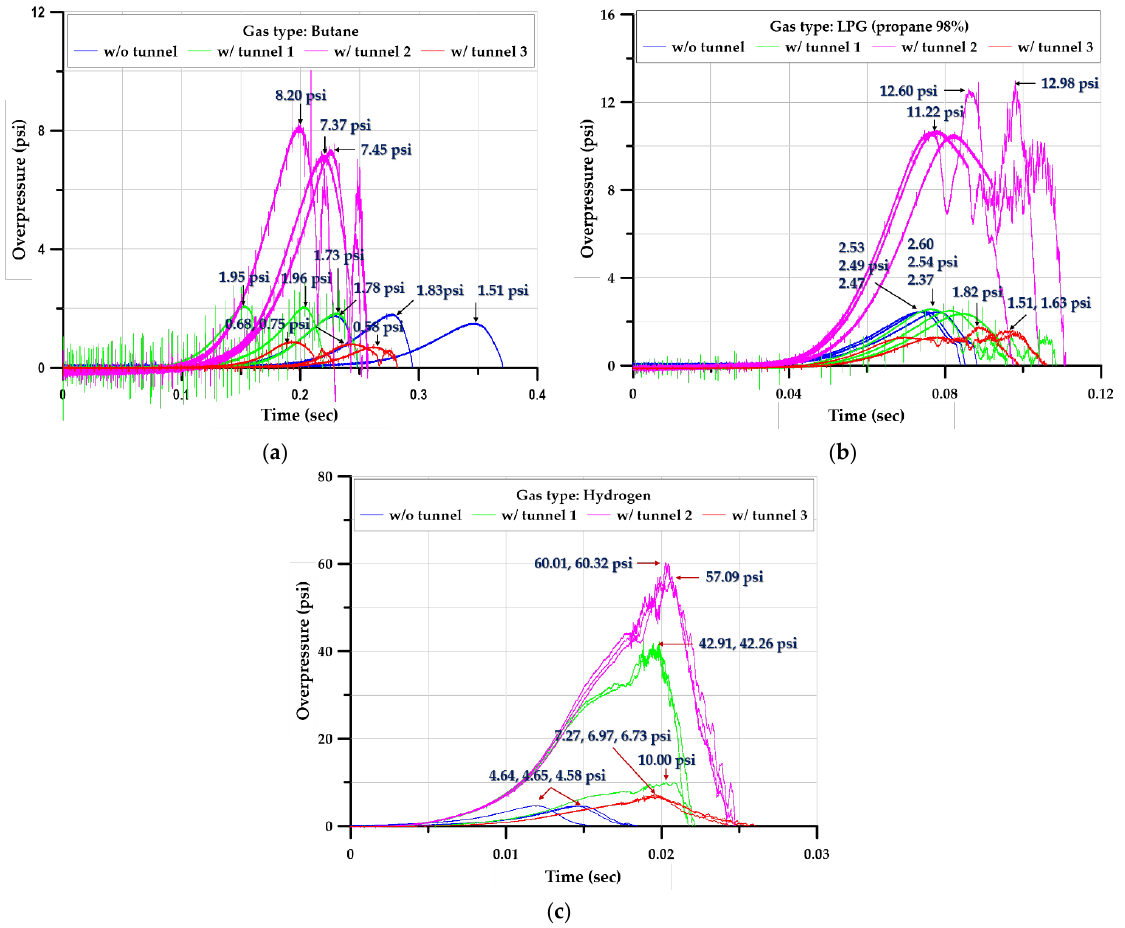
Figure 8. Time – pressure profiles inside the chamber (cylinder-type) with and without tunnels; ( a ) Butane, ( b ) LPG (propane 98%), ( c ) Hydrogen. ( a ) Butane, ( b ) LPG (propane 98%), ( c )